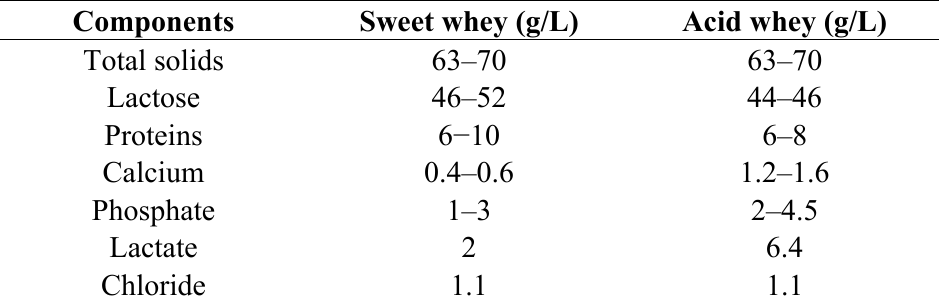
Table 1. Typical composition of sweet and acid whey